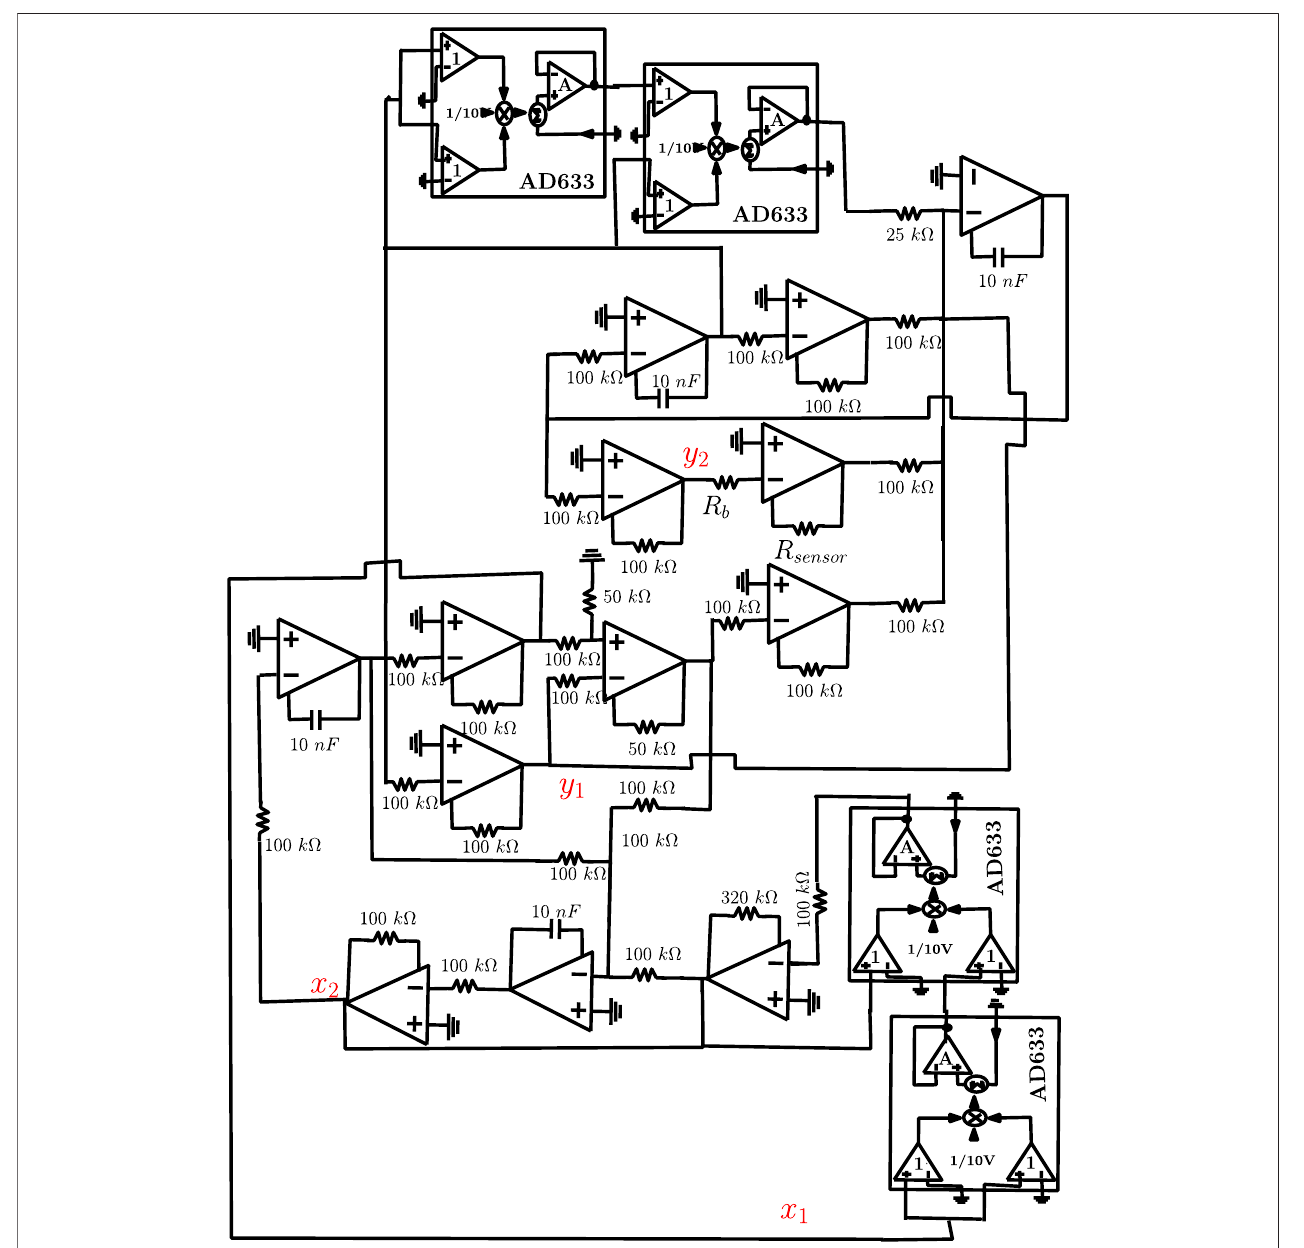
FIGURE 1 | Schematic integrated circuit of the van der Pol and Duf fi ng damped oscillators coupled system, where A, B and C represent the transfer equations.